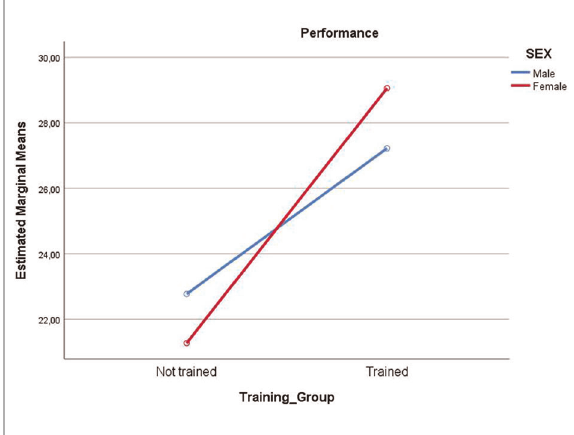
FIGURE 1 Estimated marginal means considering the effect of training and gender on